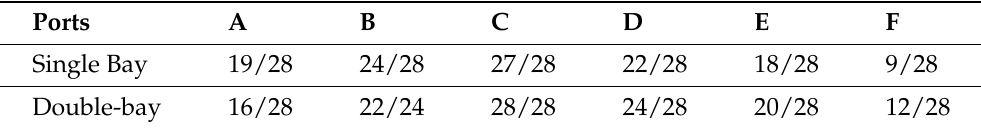
Table 9. Comparison of bay